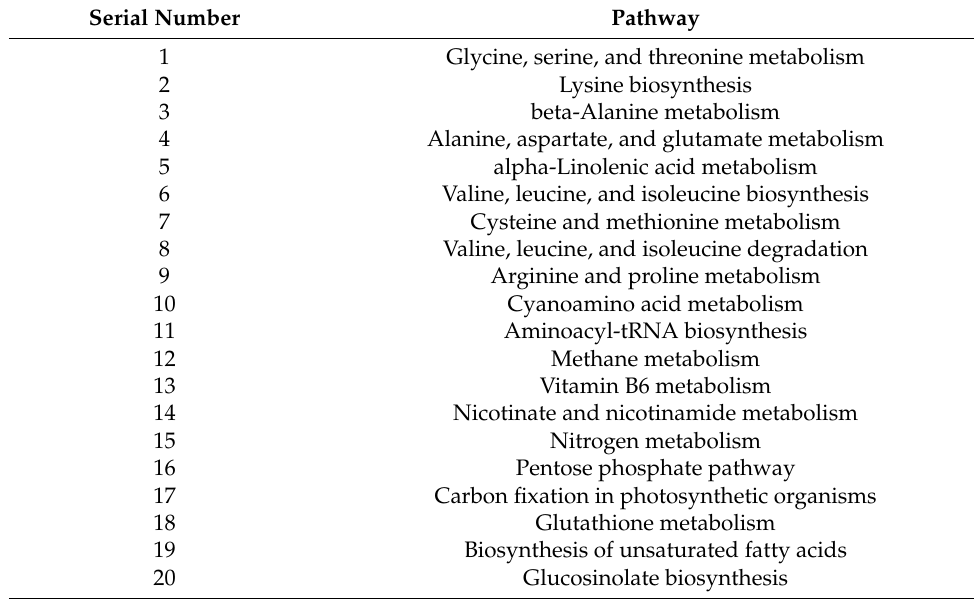
Table 4. List of factors affecting metabolic